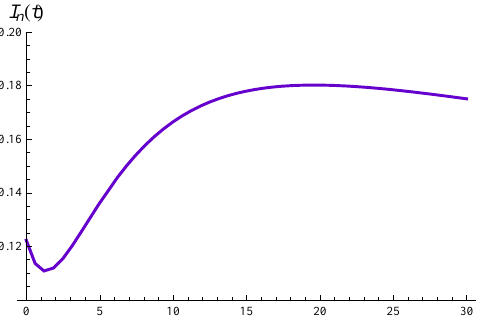
Figure 5. The intensity of losses vs. time for n = 20.